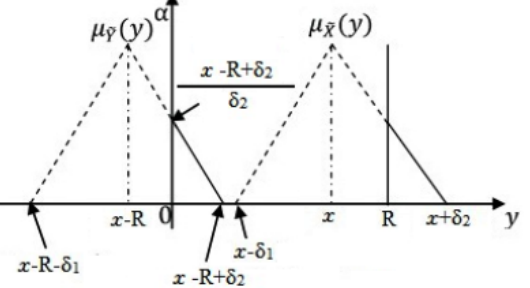
Figure 4. Membership function of the fuzzy shortage quantity when R − δ 2 ≤ x < R